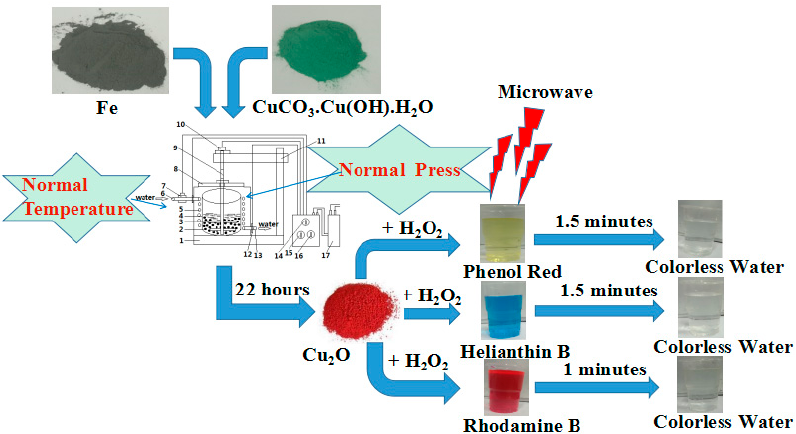
Figure 1. Scheme of Cu 2 O solid solution preparation and the test of its catalytic properties.